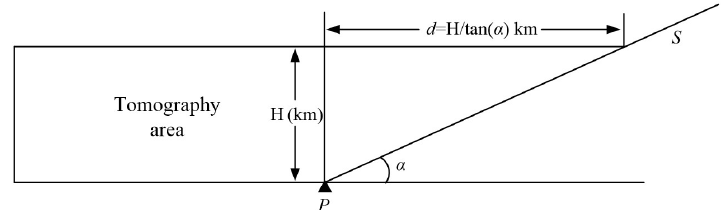
Figure 3. The schematic diagram of the calculating distance of the auxiliary